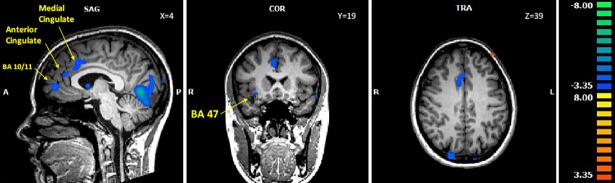
Activation differences between adolescent AN patients and controls for negative stimuli.For details see Fig 1 legend.